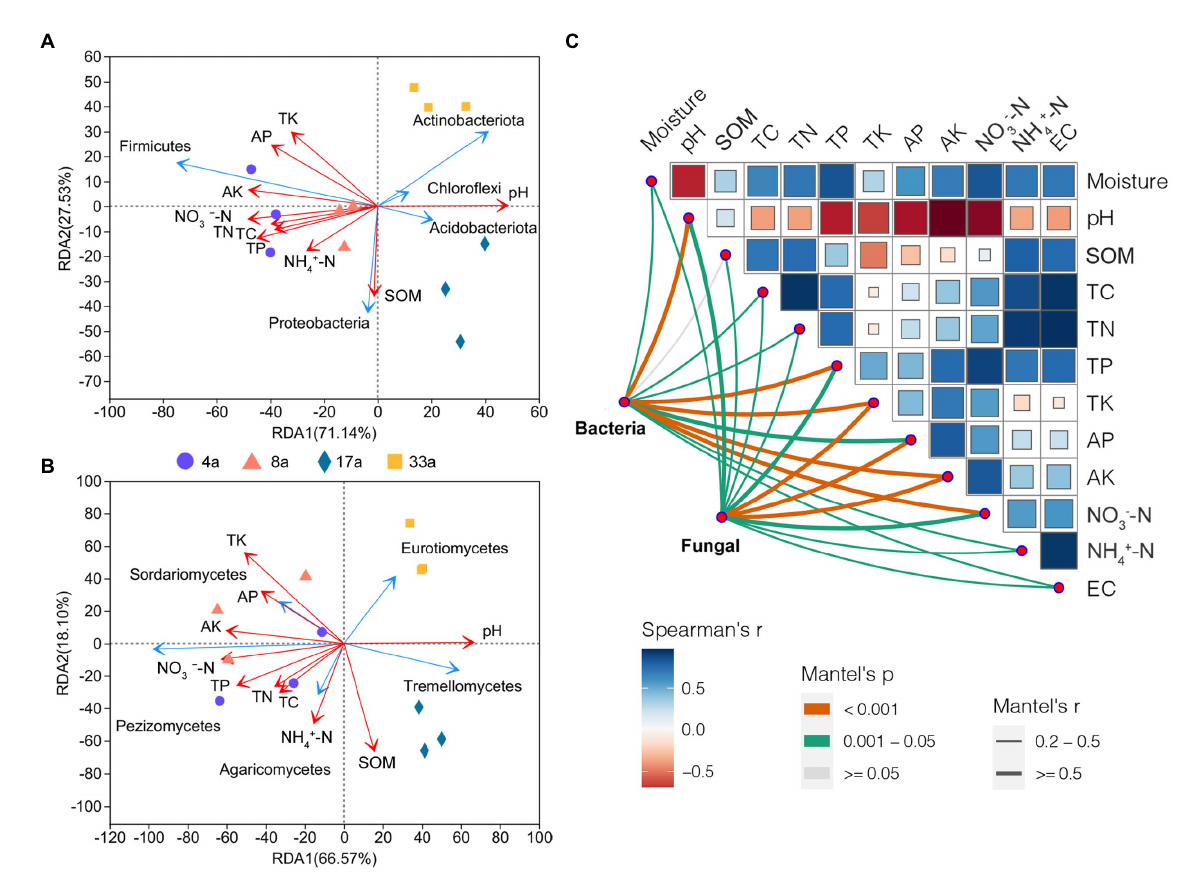
FIGURE 6 The effects of soil factors and potential drivers of the blueberry rhizosphere microbial community. Redundancy analysis (RDA) of soil physicochemical factors on bacterial (phylum level; A ) and fungal (class level; B ) community structure. Environmental drivers of blueberry rhizosphere microbial community composition based on Mantel tests (C) . The bacterial and fungal community compositions were related to each environmental factor by Mantel tests (based on Spearman’s correlations). Edge width corresponds to Mantel’s r statistic for the corresponding distance correlations, and edge color denotes the statistical significance based on 999 permutations. Correlation comparisons of Spearman’s correlation coefficients for environmental factors are shown as a color gradient. SOM, soil organic matter; TC, total carbon content; TN, total nitrogen content; TP, total phosphorus content; TK, total potassium content; NH 4+ -N, nitrate nitrogen; NO 3 − -N, ammonium nitrogen; AP, available P content; and AK, available K